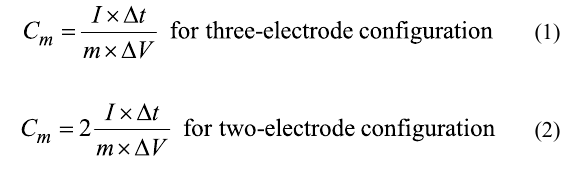
XRD pattern of CNF and PCNF shows the most relevant char- acteristic peaks at 2 θ = 25.4°, 44.2° and 2 θ = 25.1°, 44.0°, re- spectively, which correspond to (002) and (101) planes with d spacing of 0.350 nm and 0.354 nm, respectively. This clearly indicates the introduction of pores in PCNF during the decom- position of PVDF through the carbonization process. This process contributes to more disturbances and thus increases the d spacing from 0.350 nm to 0.354 nm. Also, the wide diffrac- tion peak indicates the lower degree of graphitization. The diffraction pattern of Cu/PCNF could be indexed (002), (111), (200) and (220) respectively (JCPDS card # 00-003-1005).